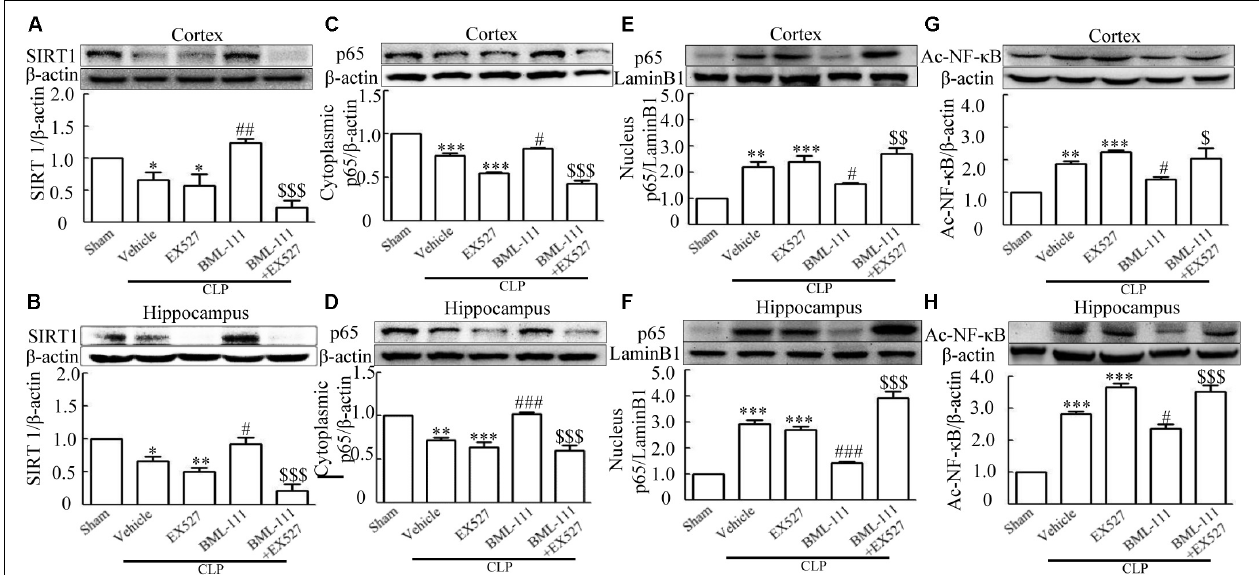
FIGURE 9 | BML-111 inhibits NF- κ B signaling pathway via SIRT1 in CLP mice. CLP and EX527 reduced the levels of SIRT1 (A,B) and cytoplasmic p65 (C,D) and increased the levels of nuclear p65 (E,F) and Ac-NF- κ B (G,H) in the cortex and hippocampus when compared with the sham group. There was no significantly difference between CLP + Vehicle group and CLP + EX527 group. BML-111 increased the levels of SIRT1 (A,B) and cytoplasmic p65 (C,D) and decreased the levels of nuclear p65 (E,F) and Ac-NF- κ B (G,H) compared with CLP + Vehicle group. EX527 administration before CLP and BML-111 reduced the levels of SIRT1 (A,B) and cytoplasmic p65 (C,D) and increased the levels of nuclear p65 (E,F) and Ac-NF- κ B (G,H) when compared with the CLP + BML-111 group. Data were shown as the means ± SEM ( n = 3 surviving mice in A , n = 5 surviving mice in B , n = 6 surviving mice in C , n = 5 surviving mice in D , n = 4 surviving mice in E , n = 6 surviving mice in F , n = 3 surviving mice in G,H ). ∗ P < 0.05, ∗∗ P < 0.01, ∗∗∗ P < 0.001 represent CLP + Vehicle vs. Sham and CLP + EX527 vs. sham, # P < 0.05, ## P < 0.01, ### P < 0.001 represent CLP + BML-111 vs. CLP + Vehicle, $ P < 0.05, $$ P < 0.01, $$$ P < 0.01 represent CLP + BML-111 + EX527 vs. CLP + BML-111.